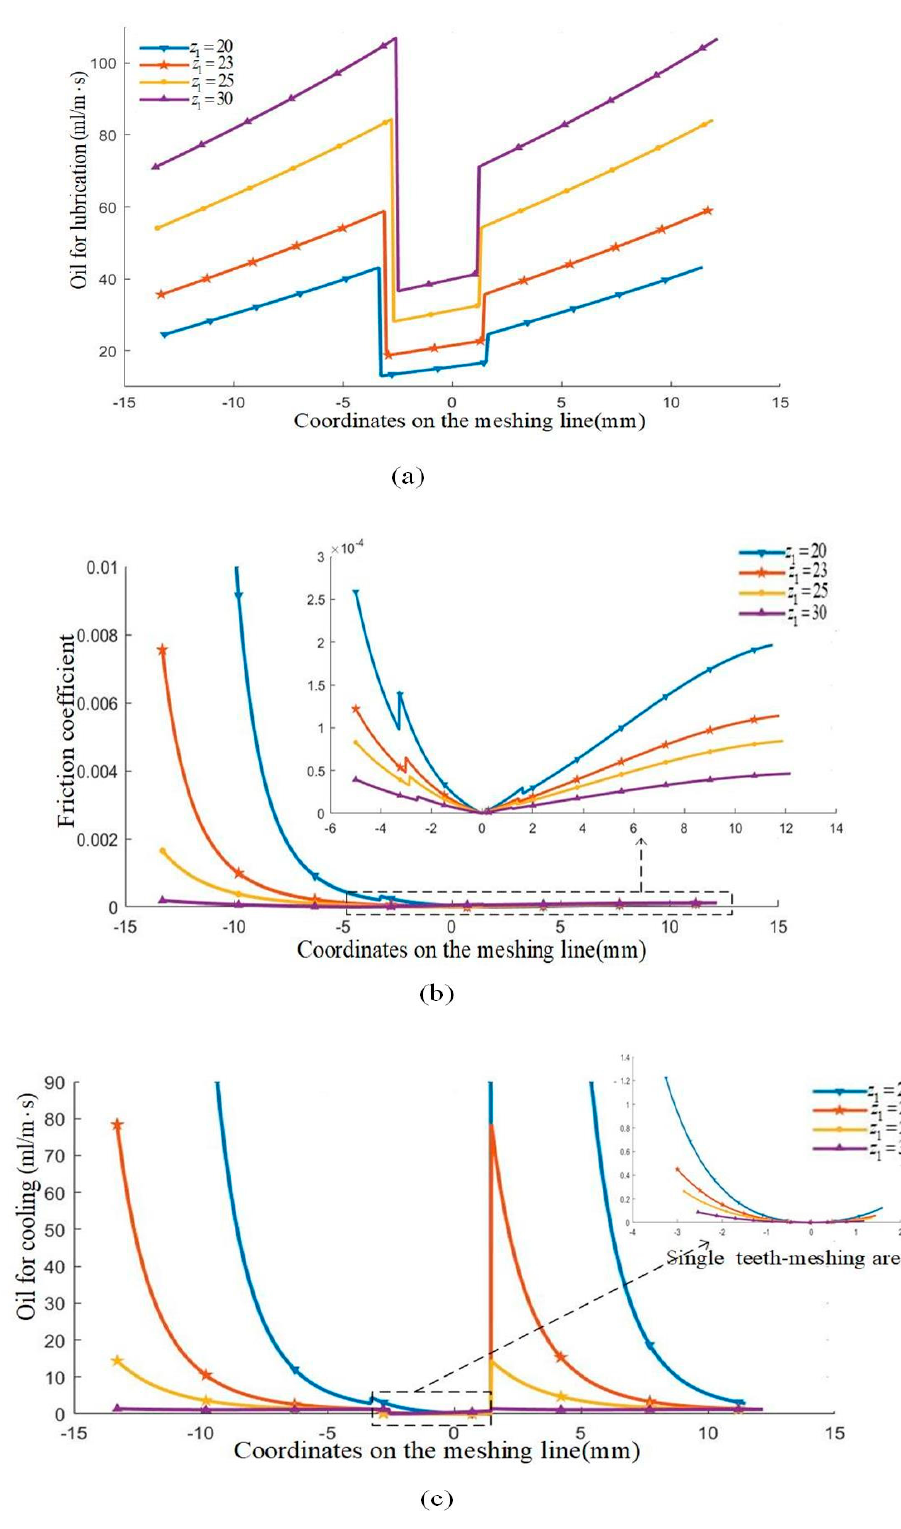
Figure 7. Oil volume for lubrication ( a ), friction coefficient ( b ), and oil volume for cooling ( c ) under different numbers of teeth during the meshing process.